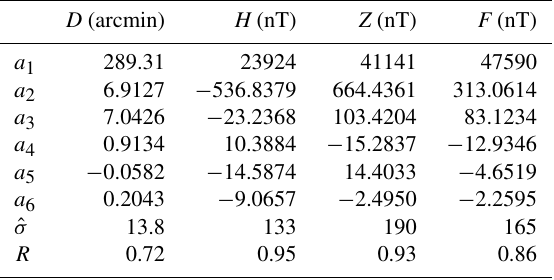
Table 1. Empirically determined statistical estimate of the coeffi- cients a 1 ,a 2 ,...,a 6 of the 2015.0 Bulgarian Geomagnetic Refer- ence Field for each field element together with the associated dis- persion ˆ σ and correlation coefficient R .